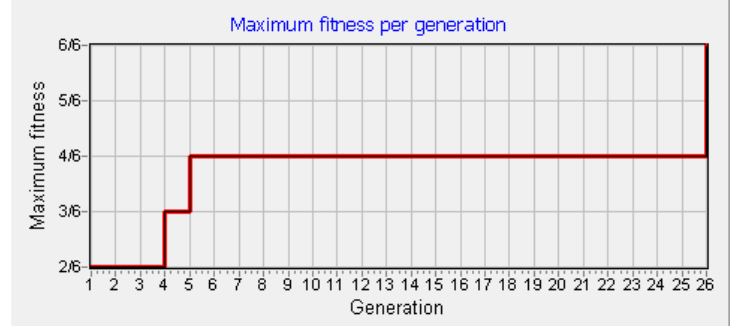
Figure 5. Maximum fitness per